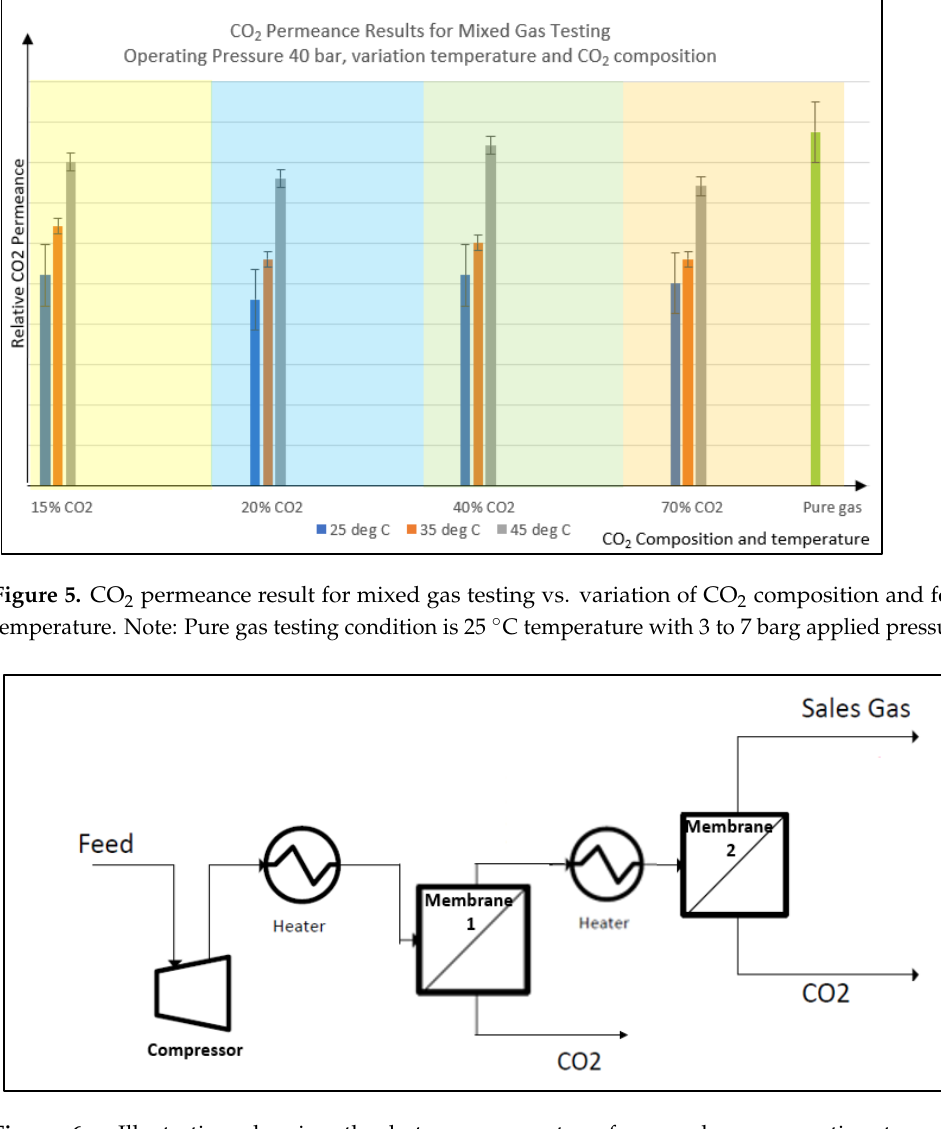
Figure 6. Illustration showing the hot process system for membrane operation to avoid liquid con- densation.